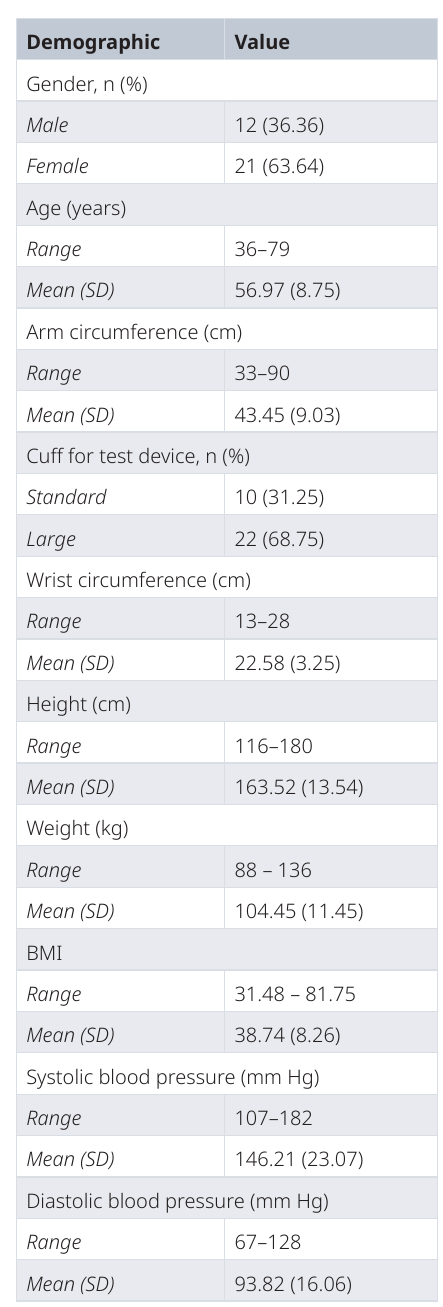
Table 2. Participant demographics